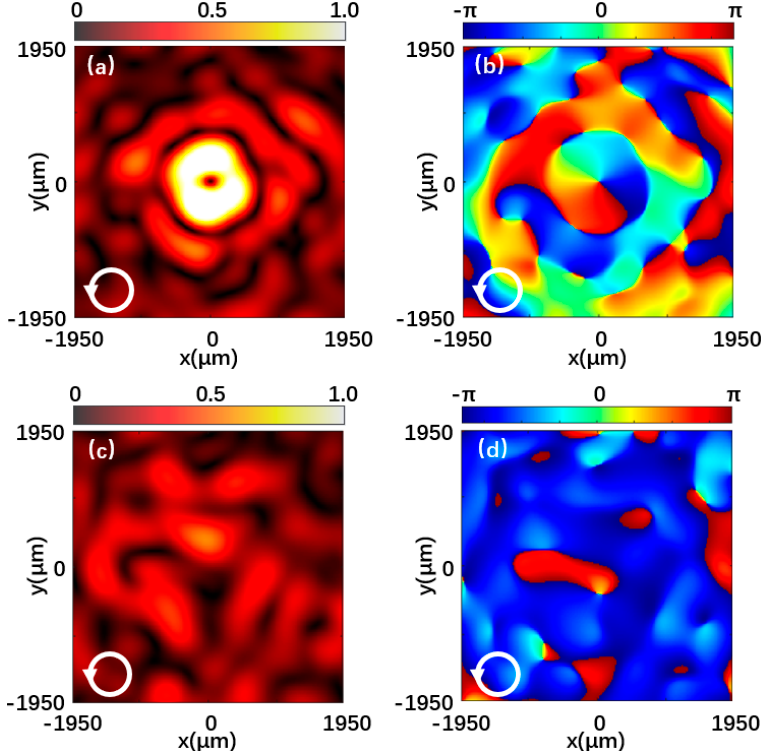
Figure 7. Reflected beam at 0.7 THz under the left-handed polarized light incidence. ( a , b ) Normalized intensity distribution and phase distribution of the left-handed component. ( c , d ) Normalized intensity distribution and phase distribution of the right-handed component.